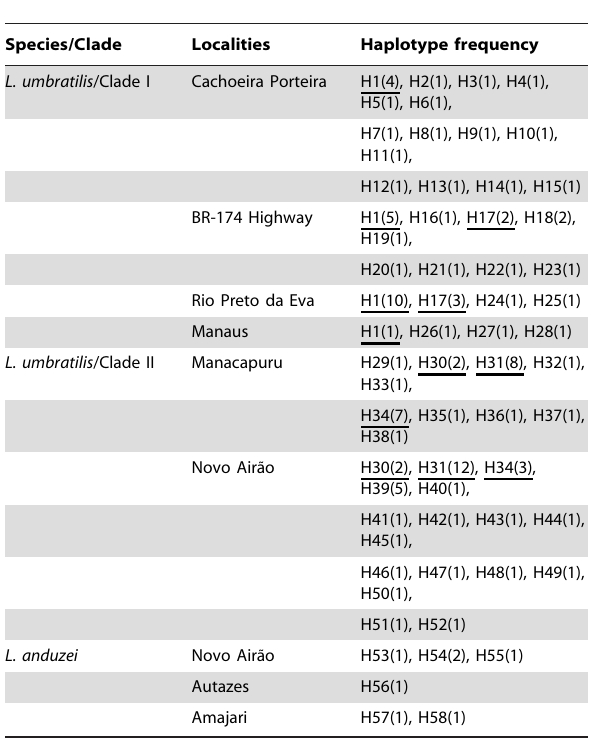
Table 2. Haplotype frequency of Lutzomyia umbratilis and Lutzomyia anduzei from Amazonian Brazil.